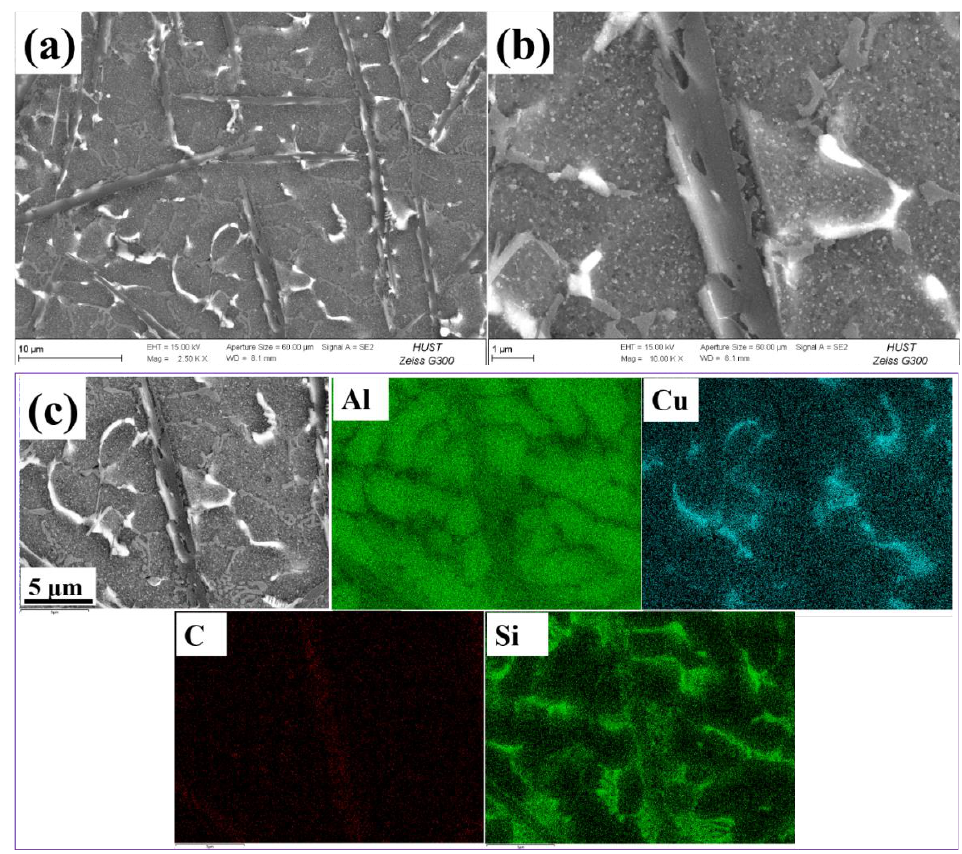
Figure 3. SEM image and elements mapping of 20 vol%SiC/2A14 joint cross section. ( a – c ) Representative sample Y1.